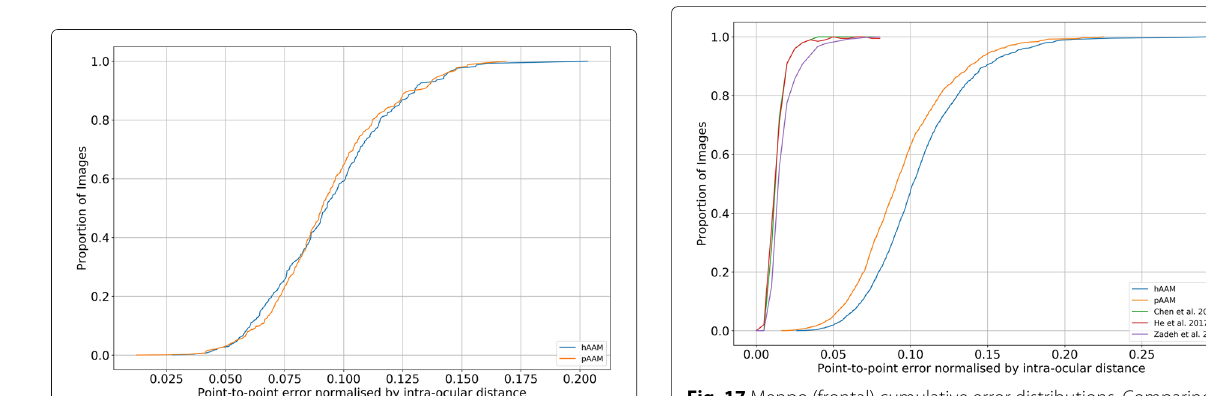
Fig. 17 Menpo (frontal) cumulative error distributions. Comparing the performance of holistic AAMs, patch AAMs, and the performance reported by Chen et al. [63], He et al. [67], and Zadeh et al.